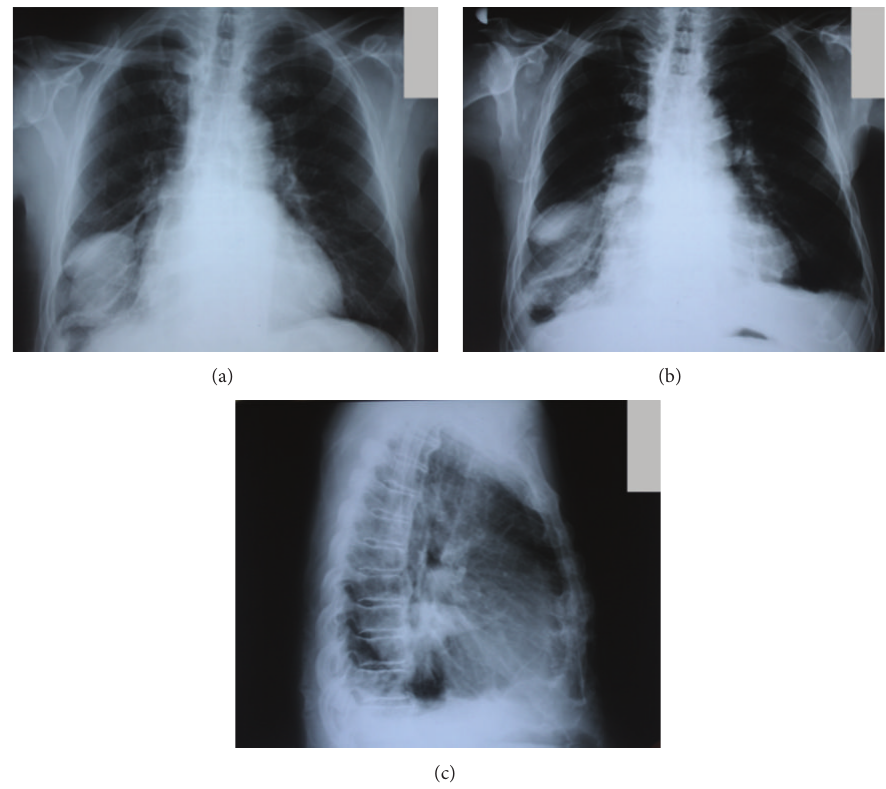
Figure 2: Archive chest-X-ray. (a) Chest-X-ray examinations undergone 4 years prior to admission showed similar tumor-like shadows in the same region of the right lobe. (b) Posteroanterior CXR undergone 1 year prior to admission demonstrating similar homogeneous shadows in the region of the right lower lung. (c) Lateral CXR undergone concurrently 1 year prior to admission demonstrating well demarcated opacity in the posterior aspect of the